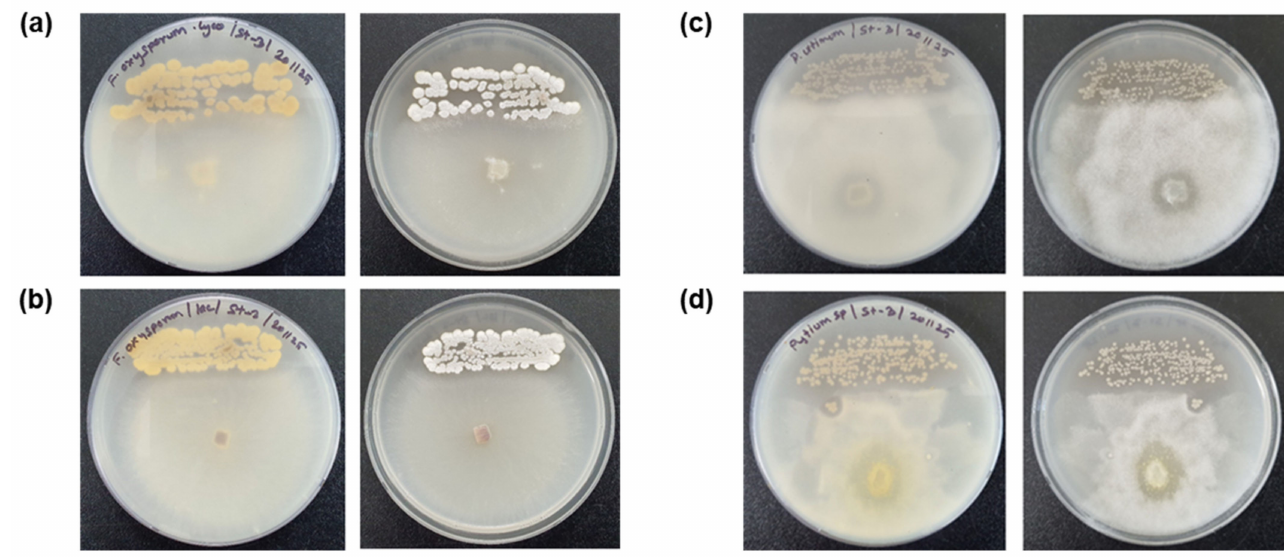
Figure 3. Analysis of the inhibitory effect of Streptomyces sasae St-3 on phytopathogens ( Fusarium oxysporum f. sp. lycopersici (KACC 40032) ( a ), Fusarium oxysporum f. sp. lactucae (KACC 42795) ( b ), Pythium ultimum (KACC 40705) ( c ), and Pythium sp. (KACC 40581) ( d